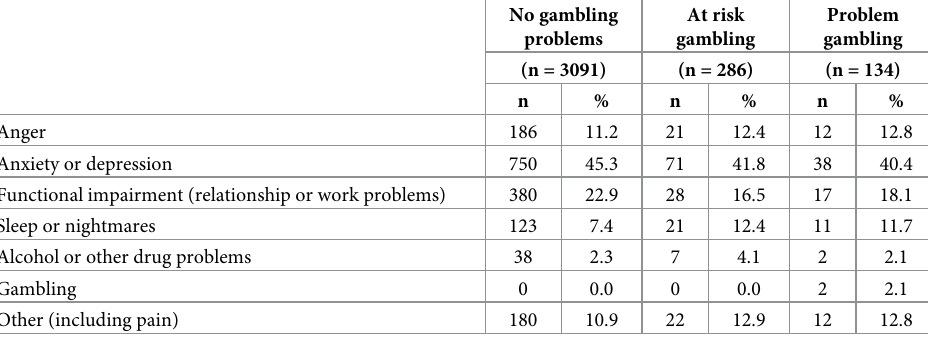
Table 3. Primary reasons for seeking care by gambling